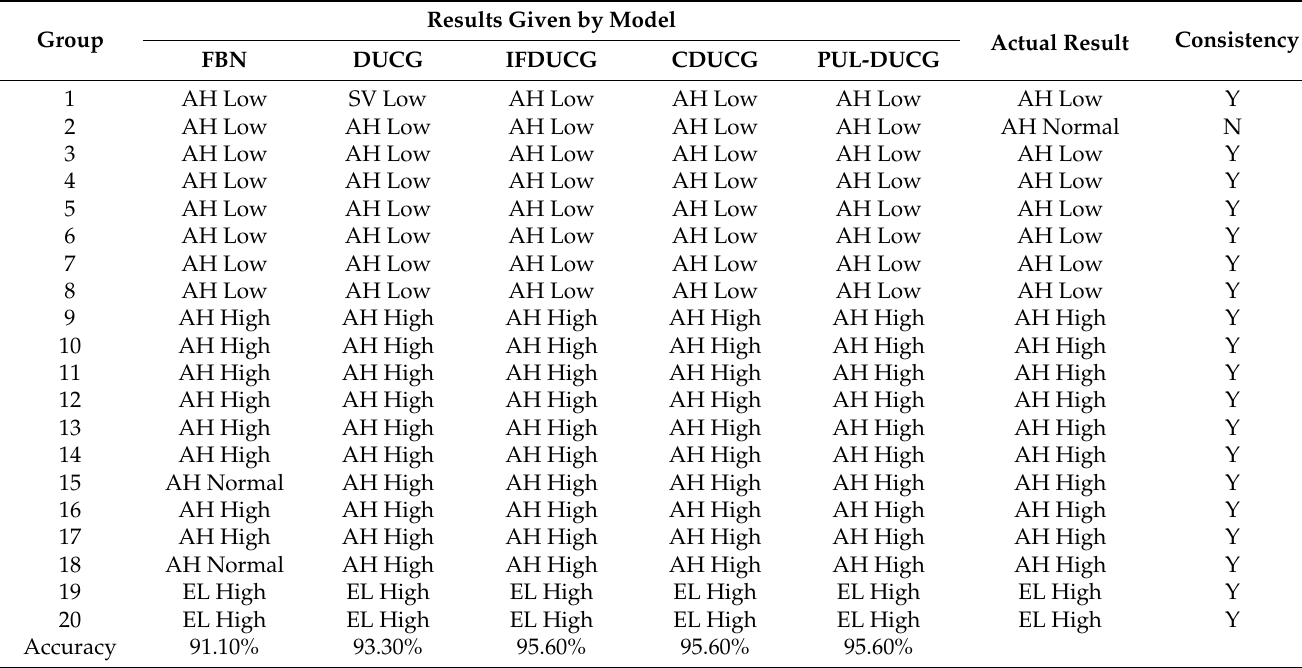
Table 6. The reasoning results according to the listed